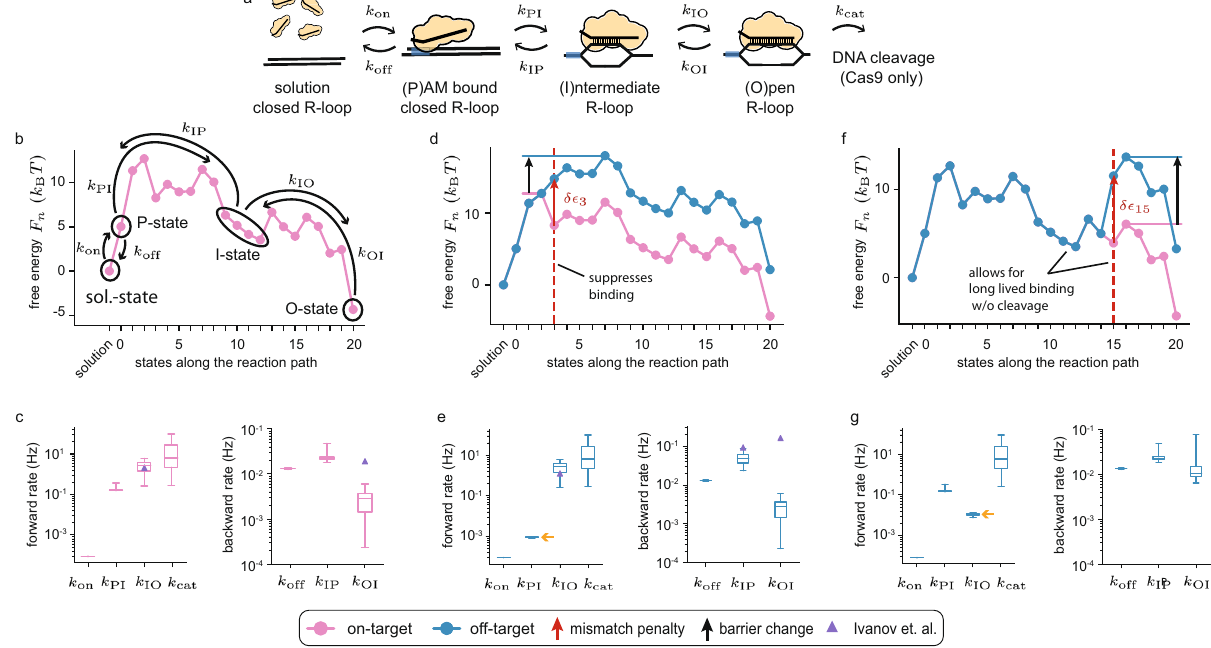
Fig. 5 Metastable states control the targeting dynamics. a) A coarse-grained version of the reaction scheme shown in Fig. 1a. Apart from the unbound and post-cleavage state, the targeting-reaction pathway is reduced to just three states: PAM bound and R-loop closed (0 bp hybrid), intermediate R-loop (7 – 13 np hybrid), and open R-loop (20 bp hybrid). b Microscopic free-energy landscape for the on-target exposed to 1 nM (d)Cas9-sgRNA (Fig. 4a) with coarse-grained states and rates indicated in black. c The calculated (see Methods) coarse-grained forward and backward rates on the on-target. Purple triangles are rates from Ivanov et al . 42 , when available at zero torque. d Microscopic free-energy landscape for an off-target with a mismatch at position 3 (blue), together with the on-target free-energy landscape (pink). Red arrow indicates the free-energy penalty δ ϵ 3 at the mismatch, and black arrow indicates the resulting shift in barrier height. e The calculated coarse-grained forward and backward rates on an off-target with a mismatch at position 3. Orange arrow highlights the rate that changed considerably compared to on-target. Purple triangles are rates from Ivanov et al . 42 , when available at zero torque. f Microscopic free-energy landscape for an off-target with a mismatch at position 15 (blue), together with the on-target free-energy landscape (pink). Red arrow indicates free-energy penalty δ ϵ 15 at the mismatch, and black arrow indicates the resulting shift in barrier height. g The calculated coarse- grained forward and backward rates on an off-target with a mismatch at position 15. Orange arrow highlights the rate that changed considerably compared to on-target. In Fig. 5c, e, and g, central line represents the median, the box plots represent the interquartile range, and whiskers represent the full range among our 33 near equivalent solutions.